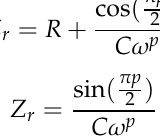
Table 4. Equivalent circuit parameters of low-conductivity films.